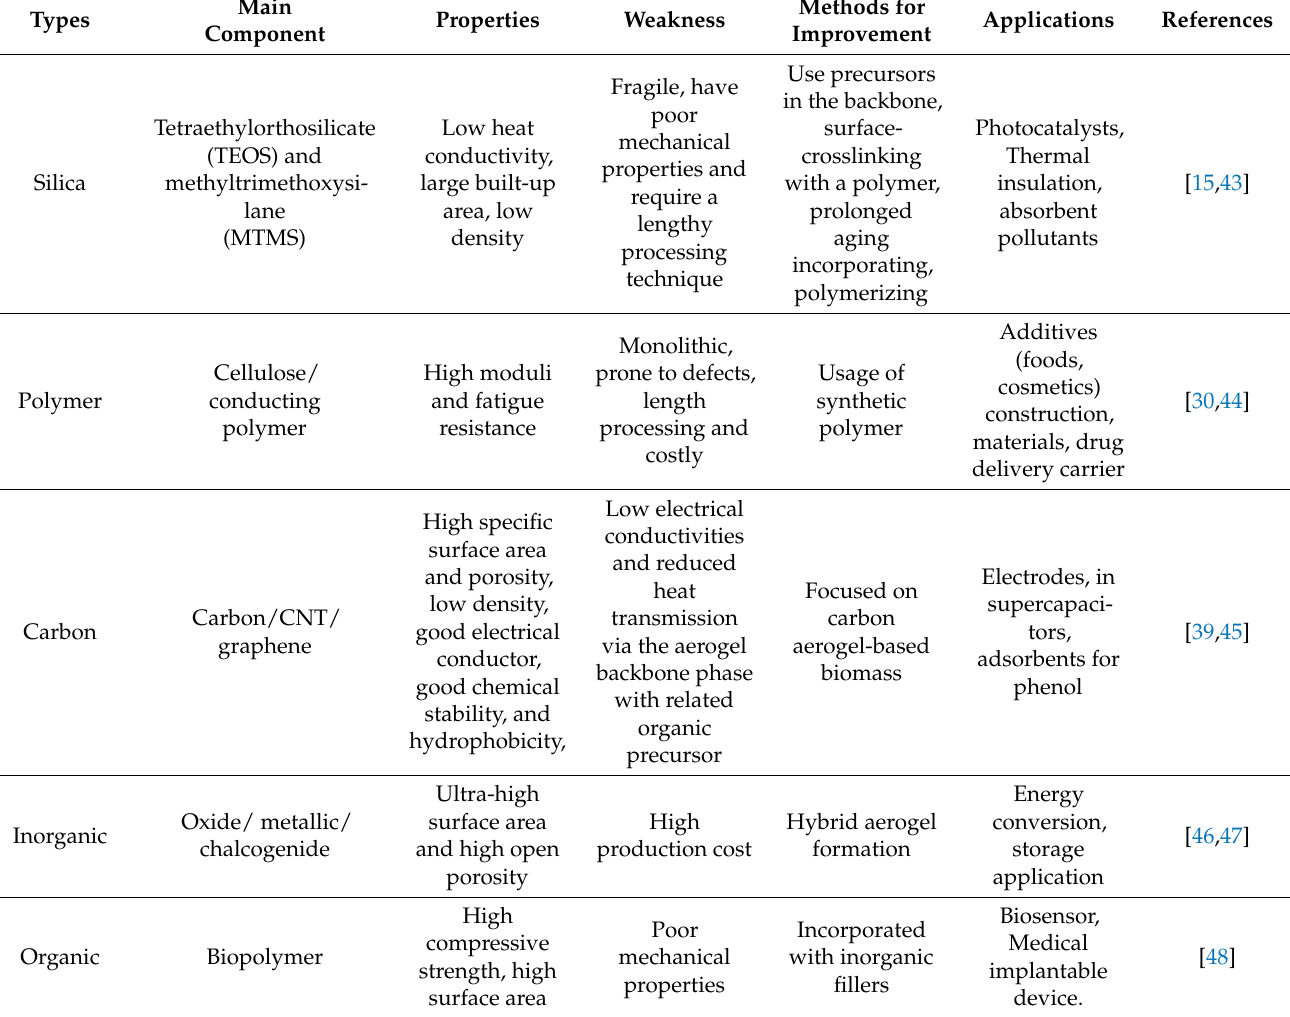
Table 1. Different types of aerogels with their respective